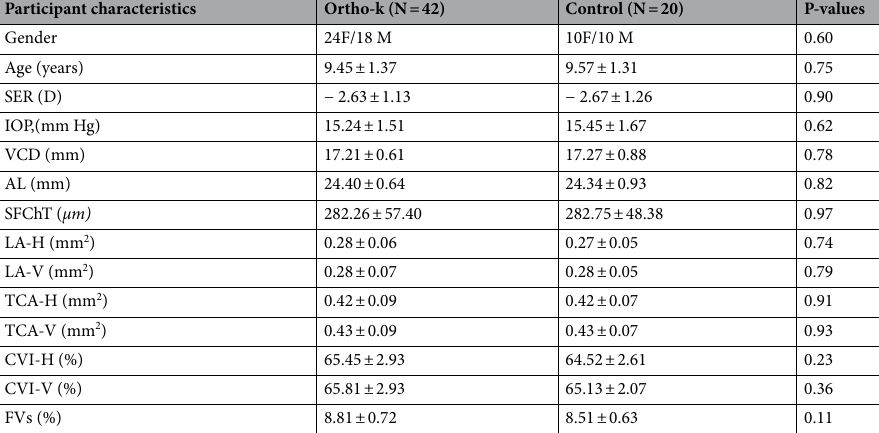
Table 1. Demographic and biometric and choroidal parameters (mean ± SD) at baseline between two groups. Subjects data presented are means ± standard deviations, except for gender. SER: spherical equivalent refractive error, IOP: intraocular pressure, VCD: vitreous chamber depth, AL: axial length, SFChT: sub-foveal choroidal thickness, LA-H: choroidal vascular luminal area on horizontal scan, LA-V: choroidal vascular luminal area on vertical scan, TCA-H: total choroidal area on horizontal scan, TCA-V: total choroidal area on vertical scan, CVI-H: choroidal vascularity index on horizontal scan, CVI-V: choroidal vascularity index on vertical scan, FVs: choriocapillaris flow voids. P value determined by independent sample t tests, and p < 0.05 at two tails was considered to be statistically significant.